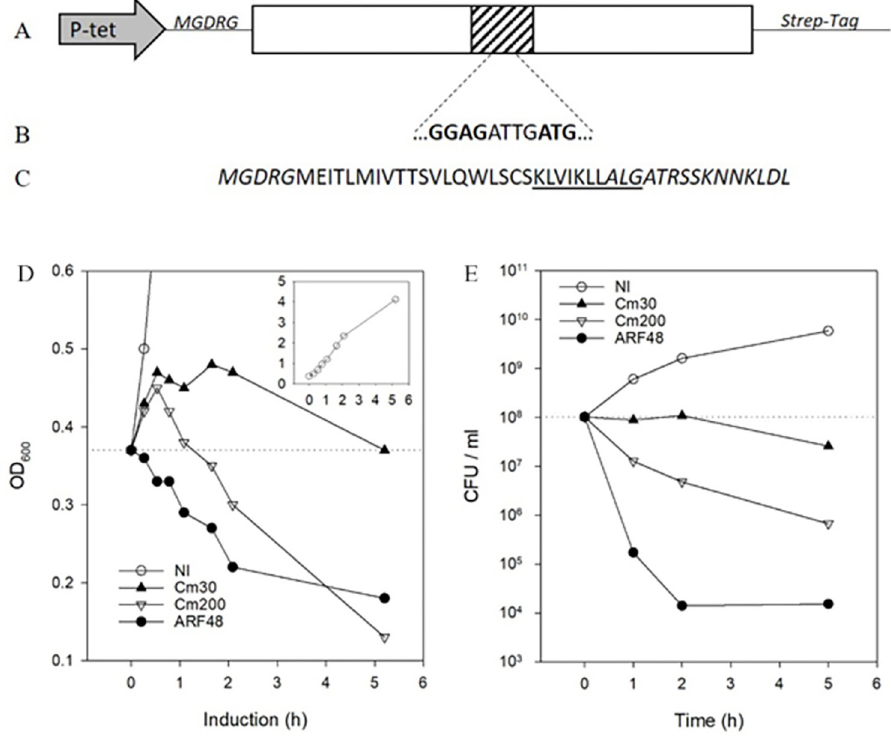
Fig 2. An alternate reading frame-encoded polypeptide is toxic when expressed in E . coli . A, an Arabidopsis thaliana cDNA (Genbank accession At3G62370; open rectangle) that was acutely toxic when expressed in E . coli from the inducible Tet promoter (P-tet arrow) in pASK-IBA3. Deletion studies showed that an internal region of cDNA (shaded box, not drawn to scale) was sufficient for the toxic effect. B, a Shine-Dalgarno-like sequence [23] contained within the toxic region of cDNA. The ATG initiation codon for this putative translation start site is positioned in the +1 alternate reading frame (ARF) relative to the cDNA-encoded plant protein. C, the ARF-encoded 48-residue protein (ARF48) produced when the coding sequence was translated from the start site in pASK-IBA3. A 10-residue sequence (KL decapeptide) that was tightly bound by DnaK in vitro is underlined. Vector-encoded residues are shown in italic type. D, the effect of ARF48 expression or treatment with 30 or 200 μ g/ml Cm on growth of E . coli BL21 cells. ARF48 expression was induced by adding anhydrotetracycline (0.2 μ g/ml) to the culture medium. NI, a non-induced culture grown in parallel; inset, growth of the NI control culture. E, the effect of ARF48 expression or treatment with Cm on cell viability. Samples of culture taken at 0, 1, 2 and 5 h after ARF48 induction or treatment with Cm were serially diluted and plated on LB agar. Colonies were counted after incubating the plates overnight at 37˚C. expressed in E . coli from a cloned gene. ARF48 is encoded by an alternate reading frame in an Arabidopsis thaliana cDNA clone (Fig 2A), which we discovered was translated in E . coli from an internal position in the mRNA resembling a Shine-Dalgarno site (Fig 2B). For the studies described here, the ARF48 coding sequence was subcloned behind the inducible TetA pro- moter and bona fide translation start site in expression plasmid pASK-IBA3. The TetA pro- moter is rapidly activated following addition of the inducer anhydrotetracycline (aTc) to the culture medium, resulting in production of the 48-residue protein shown in Fig 2C. Cell divi- sion was halted immediately following induction of ARF48 expression (Fig 2D) and cell viabil- ity decreased about 10,000-fold by 2 h after induction (Fig 2E). ARF48 expression therefore mimics the bactericidal effect of aminoglycoside antibiotics [6]. By contrast, cells remained viable for several hours following growth arrest by 30 μ g/ml of the bacteriostatic antibiotic Cm (Fig 2E). At higher concentration, Cm was increasingly toxic (Fig 2E).